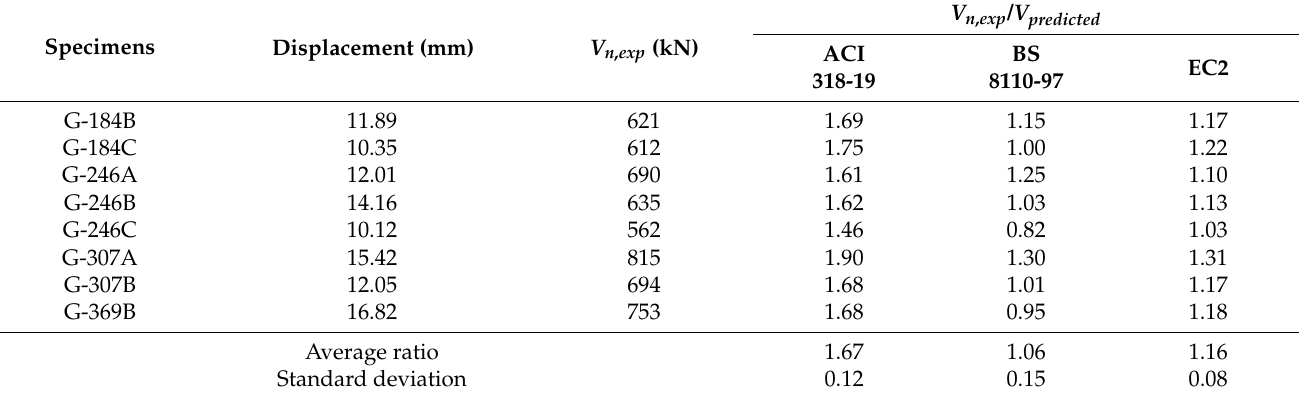
Table 5. Relative comparison between the experimental and theoretical shear